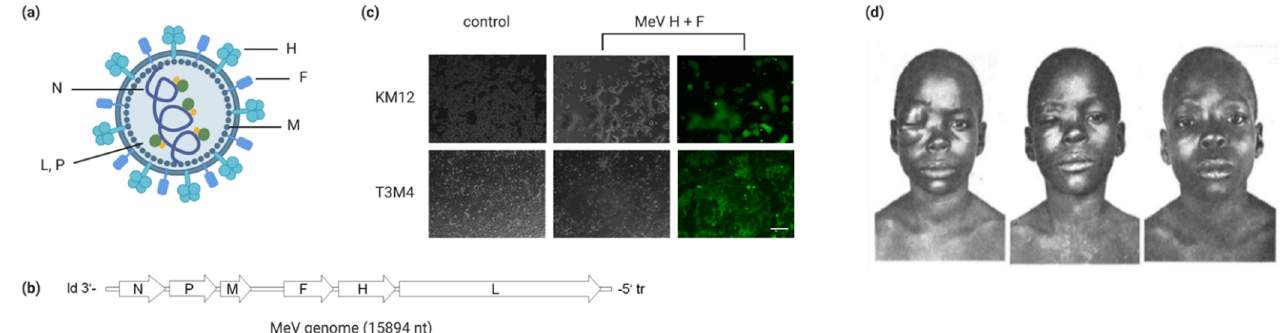
Figure 1. Measles as an oncolytic virus. ( a ) Schematic of the measles virus particle. The viral RNA genome is encapsulated by the nucleocapsid (N) protein and is associated with the viral polymerase (L, large protein) and its cofactor phosphoprotein (P), forming the ribonucleoprotein complex (RNP). The matrix (M) protein connects the RNP and the viral envelope. The surface glycoproteins hemagglutinin (H) and fusion (F) mediate receptor binding and cell fusion, respectively. ( b ) Schematic of the measles virus genome with open reading frames encoding the six structural proteins flanked by the 3 ′ leader (ld) and 5 ′ trailer (tr). ( c ) Syncytia formation as the typical cytopathic effect associated with measles virus infection. Human colorectal cancer (KM12, top) and pancreatic adenocarcinoma (T3M4, bottom) cells were transfected with plasmids encoding the MeV glycoproteins H and F as well as enhanced green fluorescent protein as reporter. Control cells were subjected to mock transfection. Phase contrast and fluorescence images were acquired with an Axiovert 200 microscope (Zeiss) at 36 h (KM12) and 12 h post-transfection (T3M4). Scale bar: 200 µ m. ( d ) Lymphoma remission after measles infection. Left panel: The patient presented with orbital Burkitt’s lymphoma. Middle panel: The patient was infected with measles; the typical skin rash is visible. Right panel: Without specific anti-lymphoma treatment, the orbital mass resolved. Reproduced from Lancet 10 July 1971; 2 (7715): 105–106, with permission.